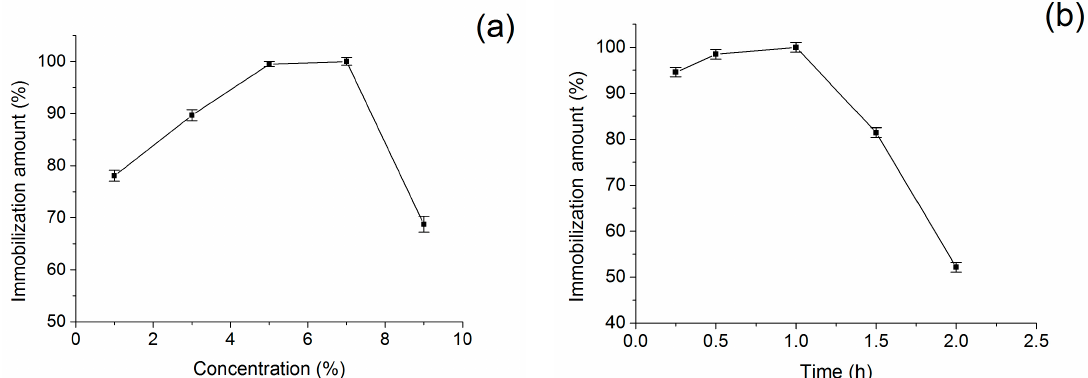
Figure 5. ( a ) Effect of glutaraldehyde concentration on immobilization when the activation time was